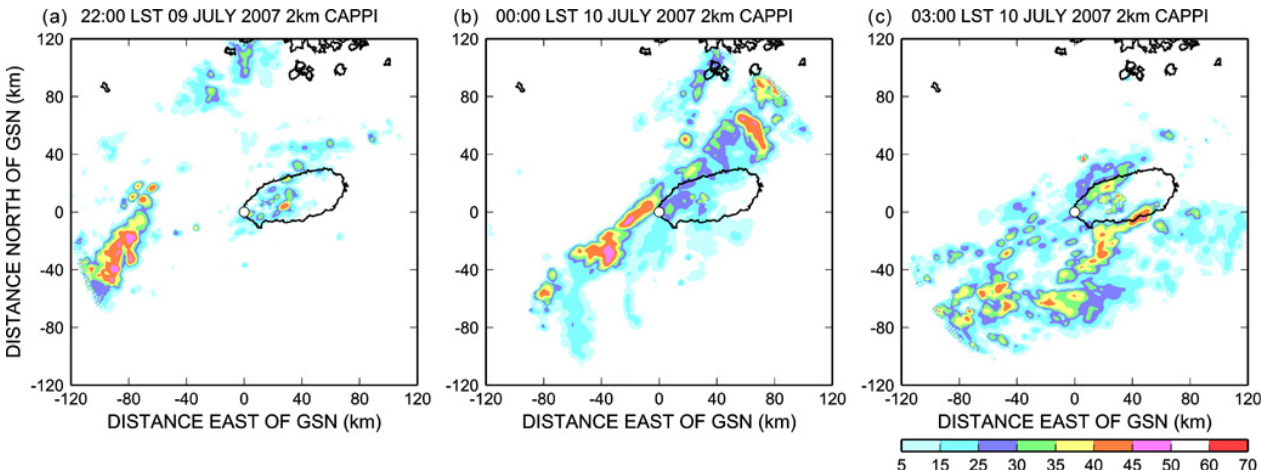
Fig. 11. Same as Fig. 9 but for (a) 22:00LST, (b) 00:00LST, and (c) 03:00LST from 9 to 10 July 2007.